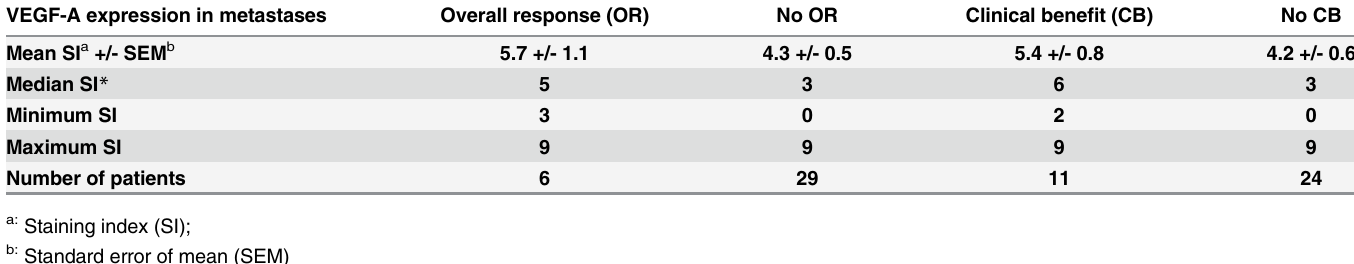
bFGF. Cytoplasmic bFGF expression was observed in 31/32 primary melanomas and all metastases; nuclear bFGF expression was seen in 30/32 primary melanomas and 28/35 metas- tases. The median nuclear SI was similar in primary tumors and metastases (p = 0.174; pWT) but the cytoplasmic SI was significantly lower in metastases (p = 0.030; pWT, S2 Fig). There was no association between expression of bFGF in primary melanomas or metastases and response to treatment. Regarding histologic features, primary tumors with a mitotic rate < 1/ mm 2 showed stronger cytoplasmic and nuclear expression of bFGF (p = 0.03 and p = 0.02; MWT), and strong nuclear expression was associated with the absence of ulceration and lower Breslow thickness (p = 0.014; MWT; p = 0.021; Kruskal-Wallis test (KWT)).